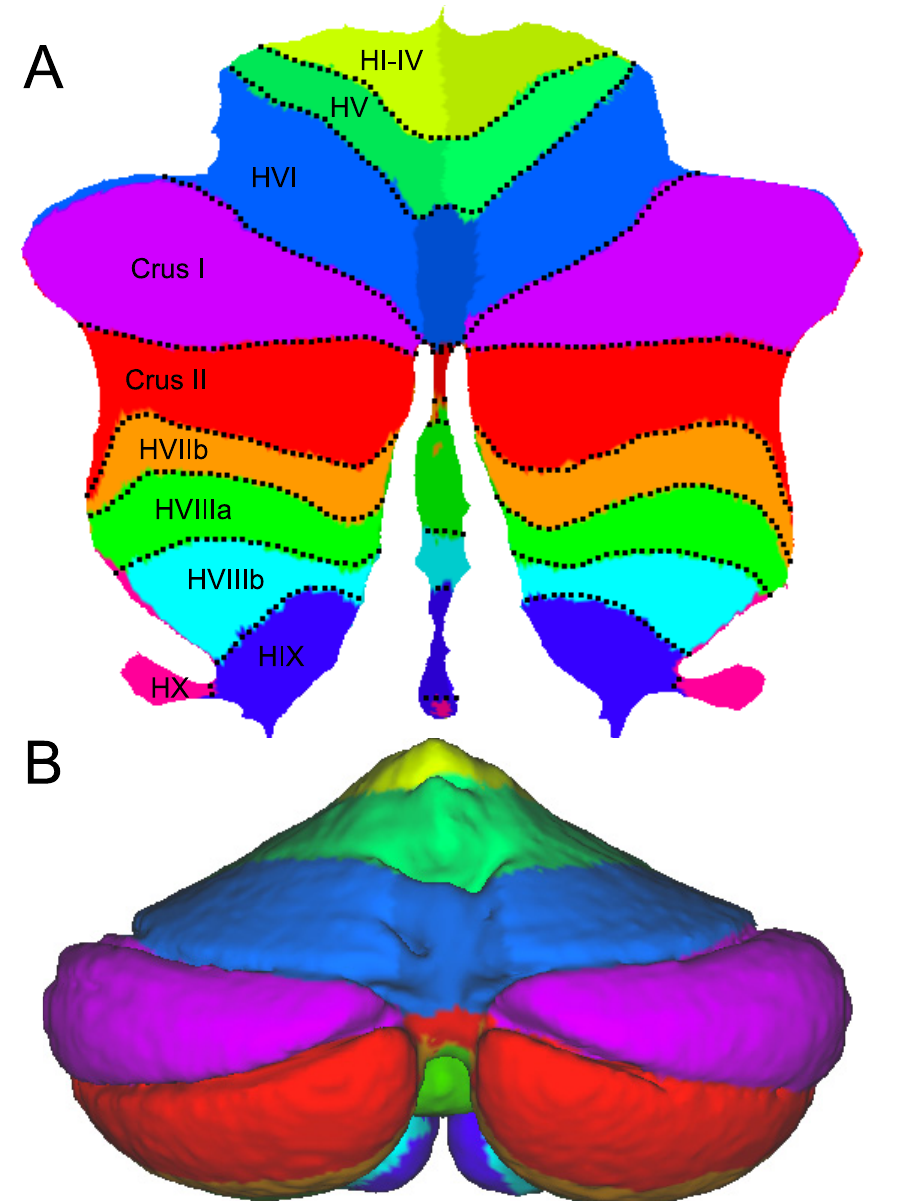
slightly different colors) are defined. ( B ) The same data displayed on a posterior view of the outer